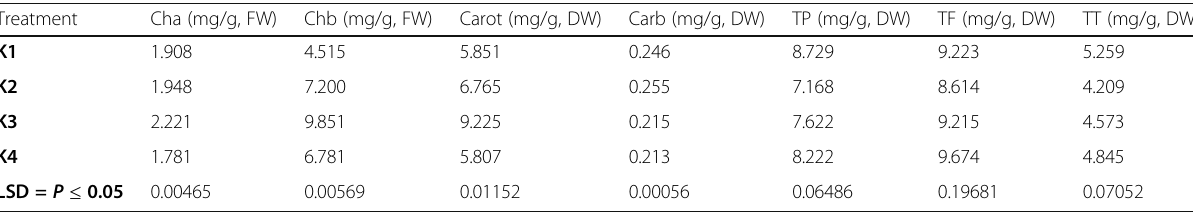
Table 2 Different kinetin treatments affect the chemical analysis of Coleus blunei (mean of two seasons)